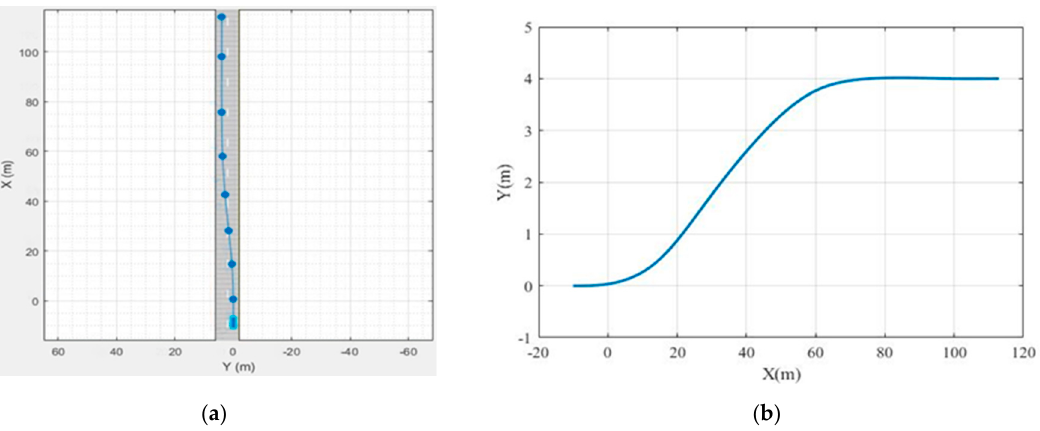
Figure 5. Driving scenario and reference path: ( a ) driving scenario; ( b ) reference path.